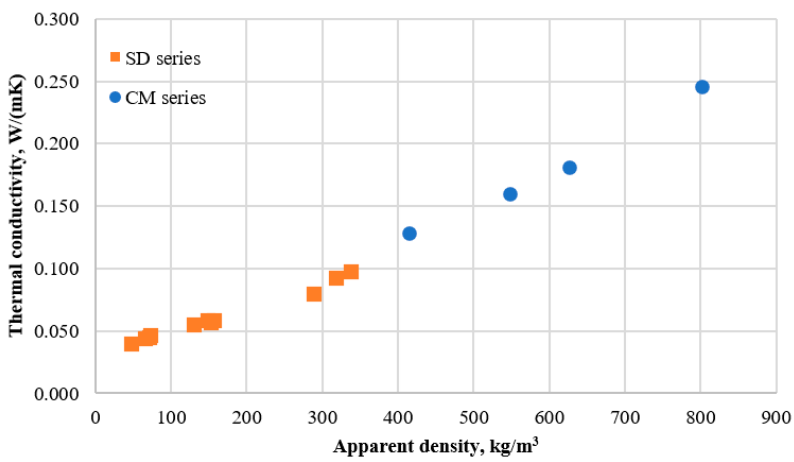
Figure 3. Relationship between apparent density and thermal conductivity of gypsum–EPS composites produced with different casting methods.